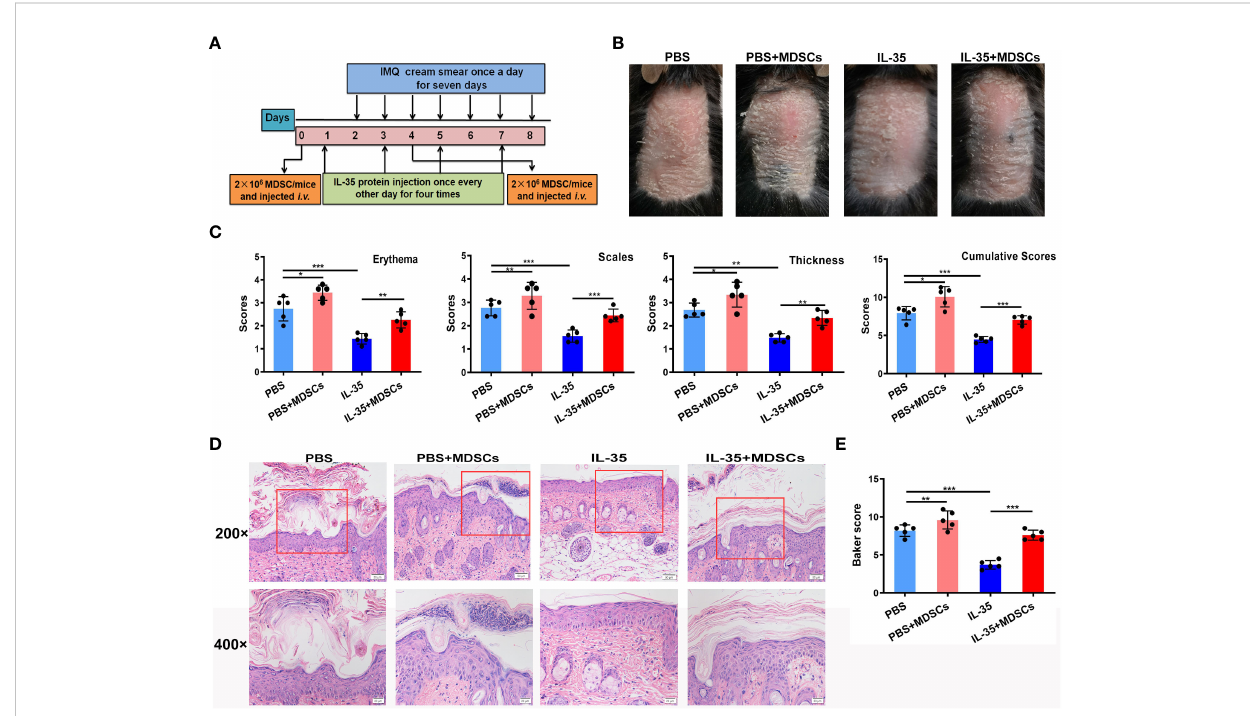
FIGURE 7 Adoptive transfer of MDSCs weakens the effect of IL-35 in mice with IMQ-induced psoriasis. (A) Experimental schedule. (B) Representative phenotype of murine skin after adoptive transfer of MDSCs. (C) PASI scoring of erythema, scaling, and thickness, and the cumulative scores for different groups. (D) H & E-stained skin sections (200× and 400× magni fi cation; the 400× image is the enlarged image in the box). (E) Pathological scores of skin sections (N = 6) using the Baker scoring system. Data are presented as means ± standard deviation. *P < 0.05, **P < 0.01, ***P < 0.001. H & E, hematoxylin and eosin; IL, interleukin; IMQ, imiquimod; MDSC, myeloid-derived suppressor cell; PASI, Psoriasis Area and Severity Index.